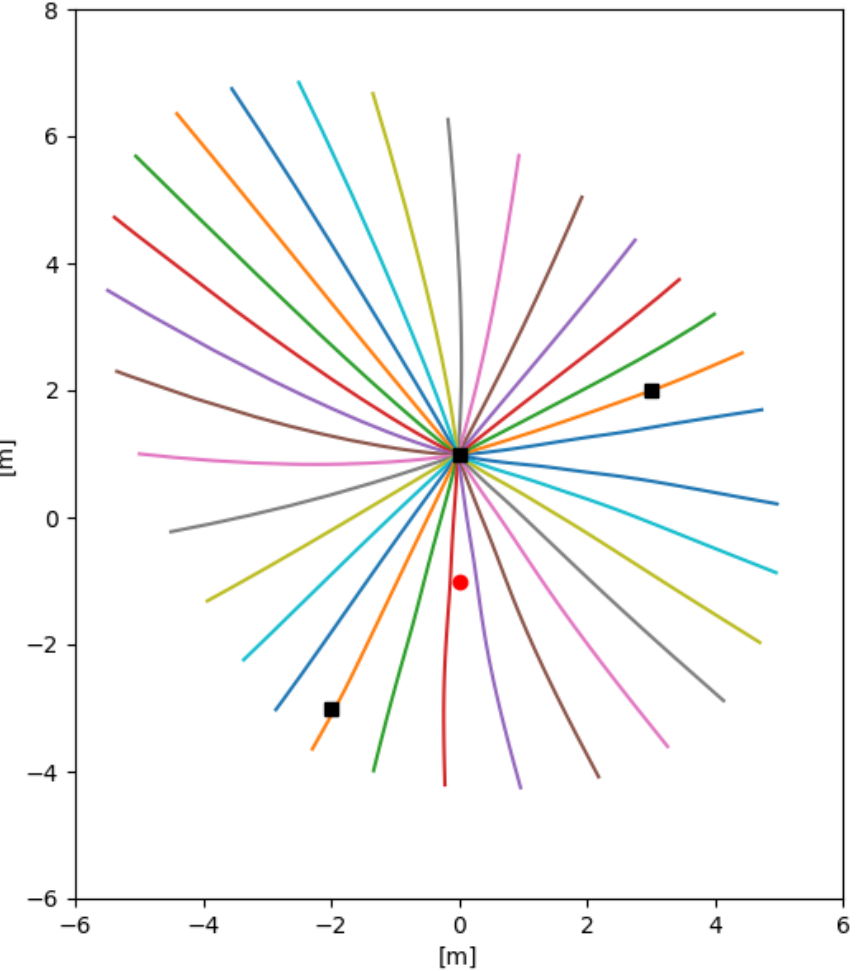
Figure 7. Solutions to the geodesic equation on Ω = [ − 10,10 ] × [ − 10,10 ] for a sensor starting at ( 0,1 ) with the other sensors stationary at ( − 2, − 3 ) and ( 3,2 ) (raised at a height 1 above Ω .). The target is located at ( 0,1 ) on Ω . The differing paths correspond to the initial direction vector ( cos φ ,sin φ ) of the target, varying as φ varies from 0 to 2 π radians in steps of 0.25